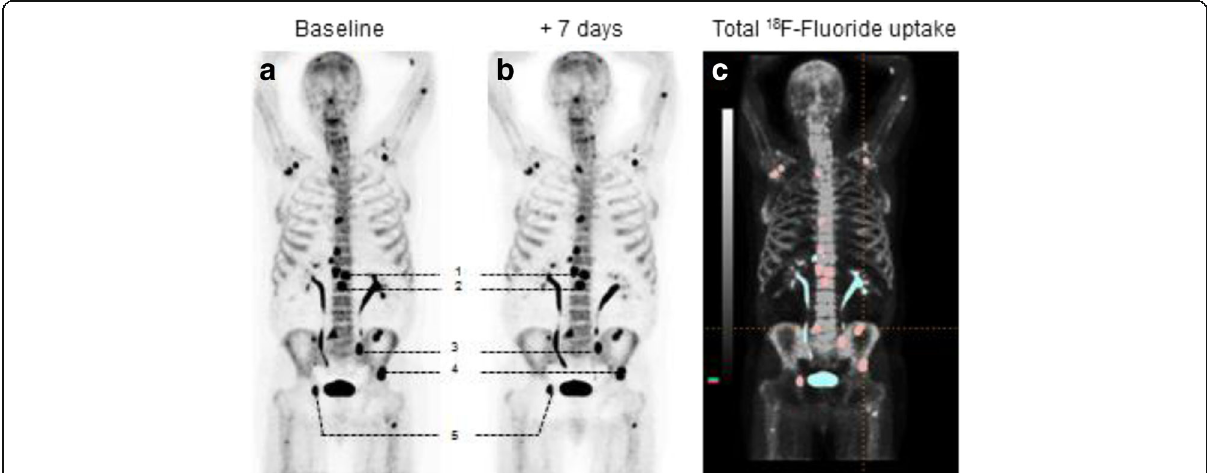
Fig. 1 Patient 8 at baseline ( a ) and at +7 days ( b ) performing PET1 and PET2. Five chosen index lesions (numbered 1 – 5) were delineated for VOI measuring SUVmax, SUVmean, FTV 50% and total lesion fluoride uptake at PET/CT (baseline). c Included lesions are highlighted in red ( n = 17) and the blue uptake represents lesions that were omitted, urine activity and degenerative or equivocal